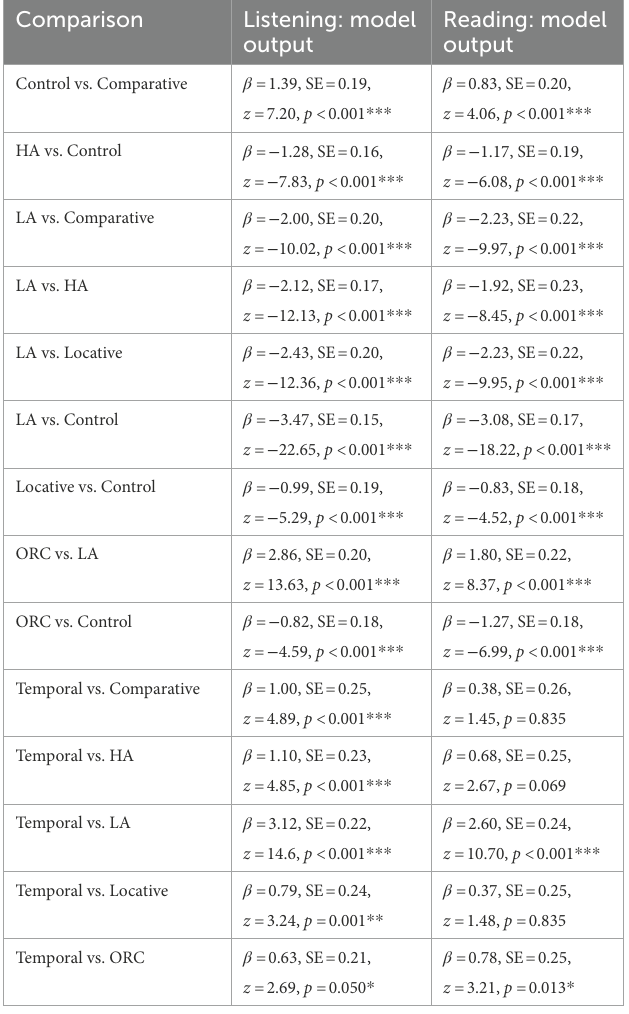
TABLE 8 Significant model outputs for accuracy analysis in Experiment 2.